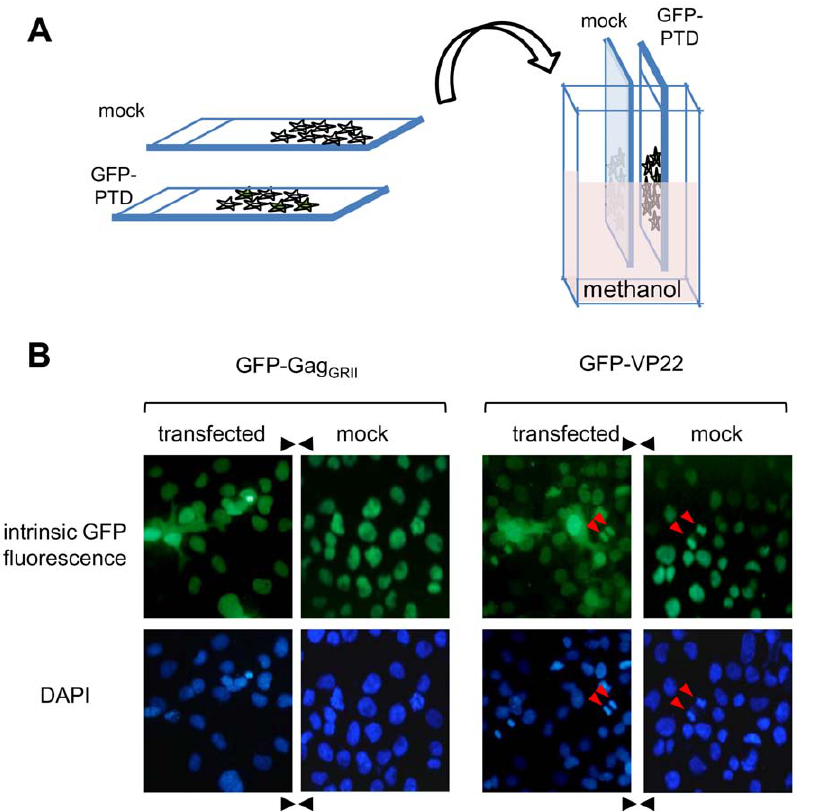
Figure 2. Extension of GFP fluorescence from cells expressing GFP-Gag GRII or GFP-VP22 Cter to recipient ones during fixation. A . Representation of the experimental procedure followed: a slide coated with cells expressing GFP-Gag GRII or GFP-VP22 Cter was abutted head to head to a slide of mock-transfected cells and, then, fixed in close contact. B . GFP-Gag GRII - or GFP-VP22-expressing cells (transfected) and mock-transfected cells (mock) were fixed with methanol in close contact and next visualized on a fluorescence microscope. Original magnification 6 40. Red arrows indicate a cell undergoing mitosis.